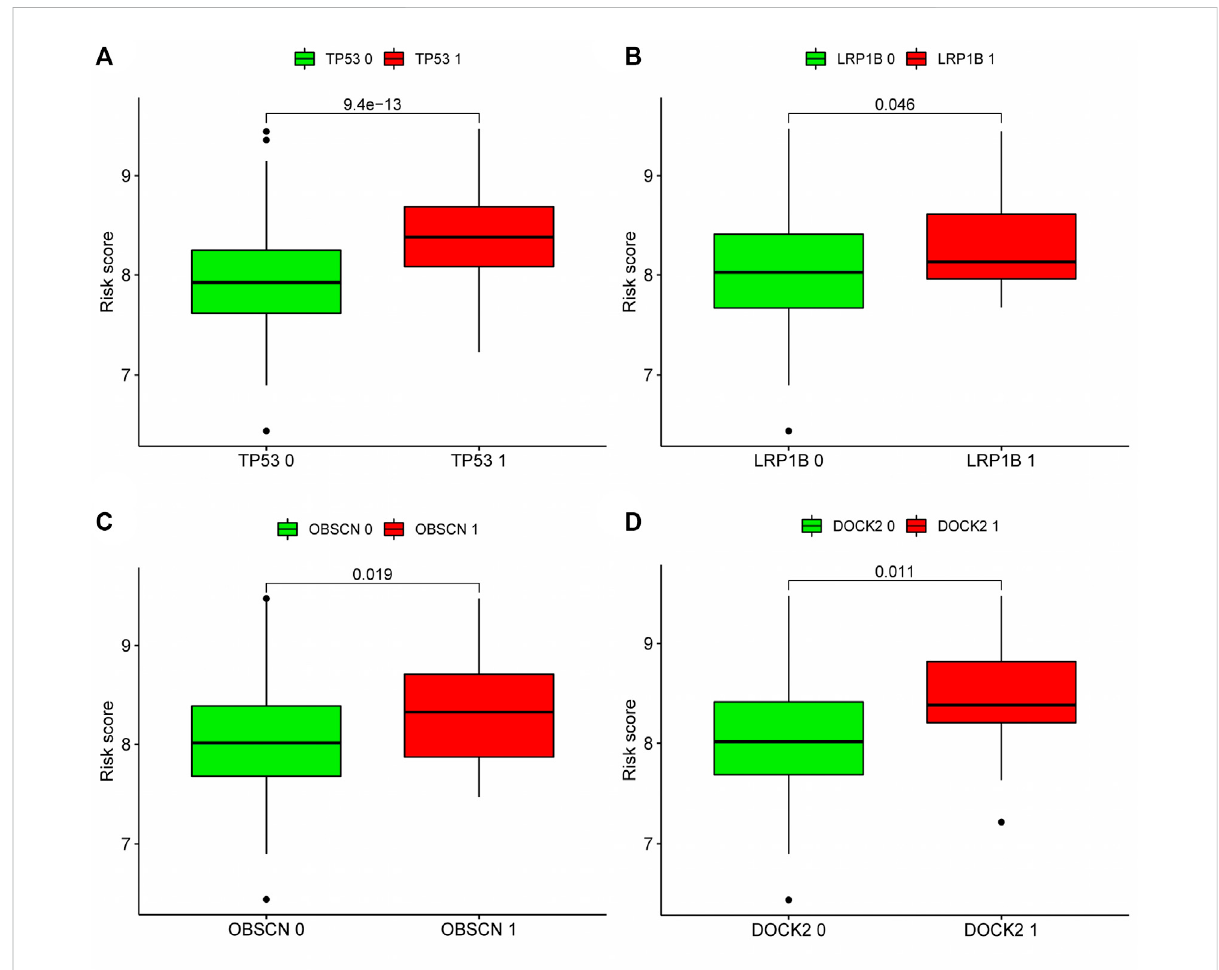
FIGURE 9 Correlation analysis between top 20 mutation genes and risk score: According to the expression level of mutant genes, patients in the TCGA cohort were divided into high-expression group and low-expression group, and whether there was difference in the risk score between the two groupswascompared. (A – D) Analyzewhetherthetop20geneswiththehighestmutationfrequencyareassociatedwiththeriskscore.Patientswith high expression of TP53, LRP1B, OBSCN and DOCK2 had higher risk scores. Green meant low expression of this gene, red meant high expression of this gene. 0: No mutation, 1: